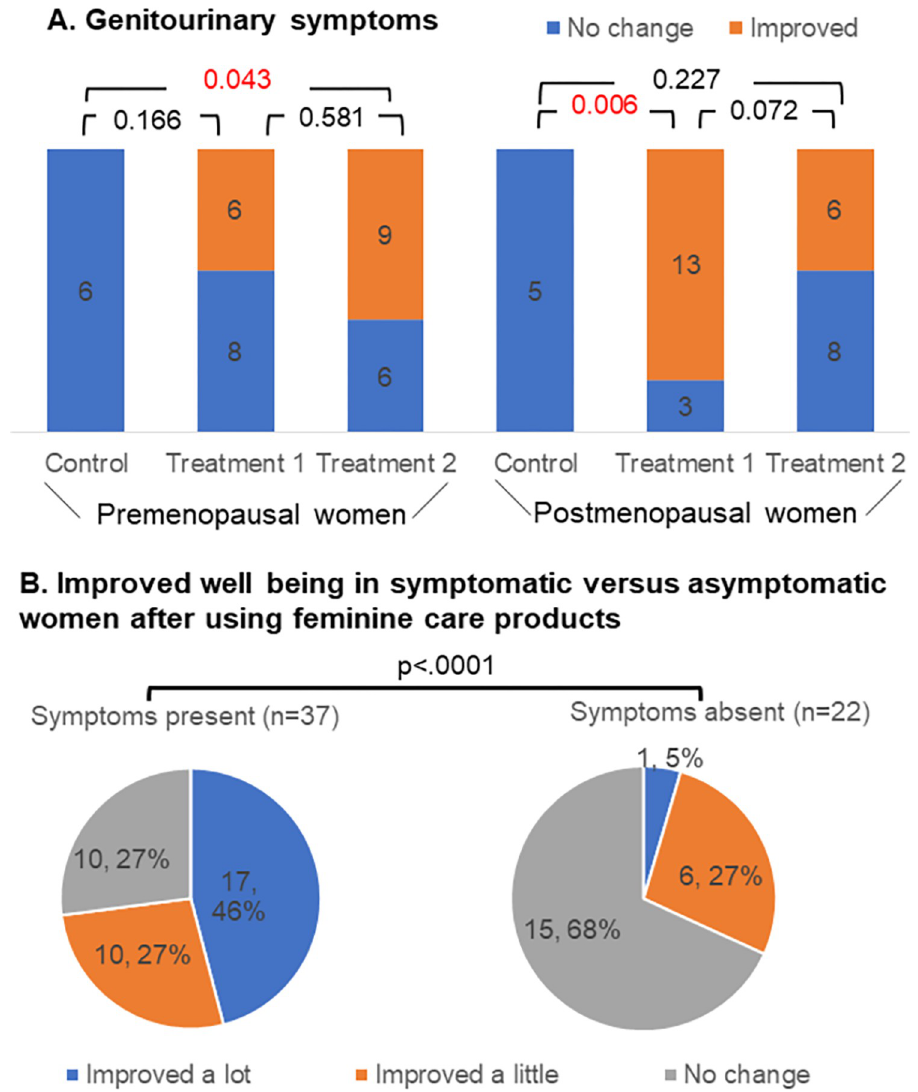
Fig 5. Changes in genitourinary symptoms after 4 weeks. Genitourinary symptoms significantly improved in treatment 2 group of premenopausal women and treatment 1 group of postmenopausal women compared to the control